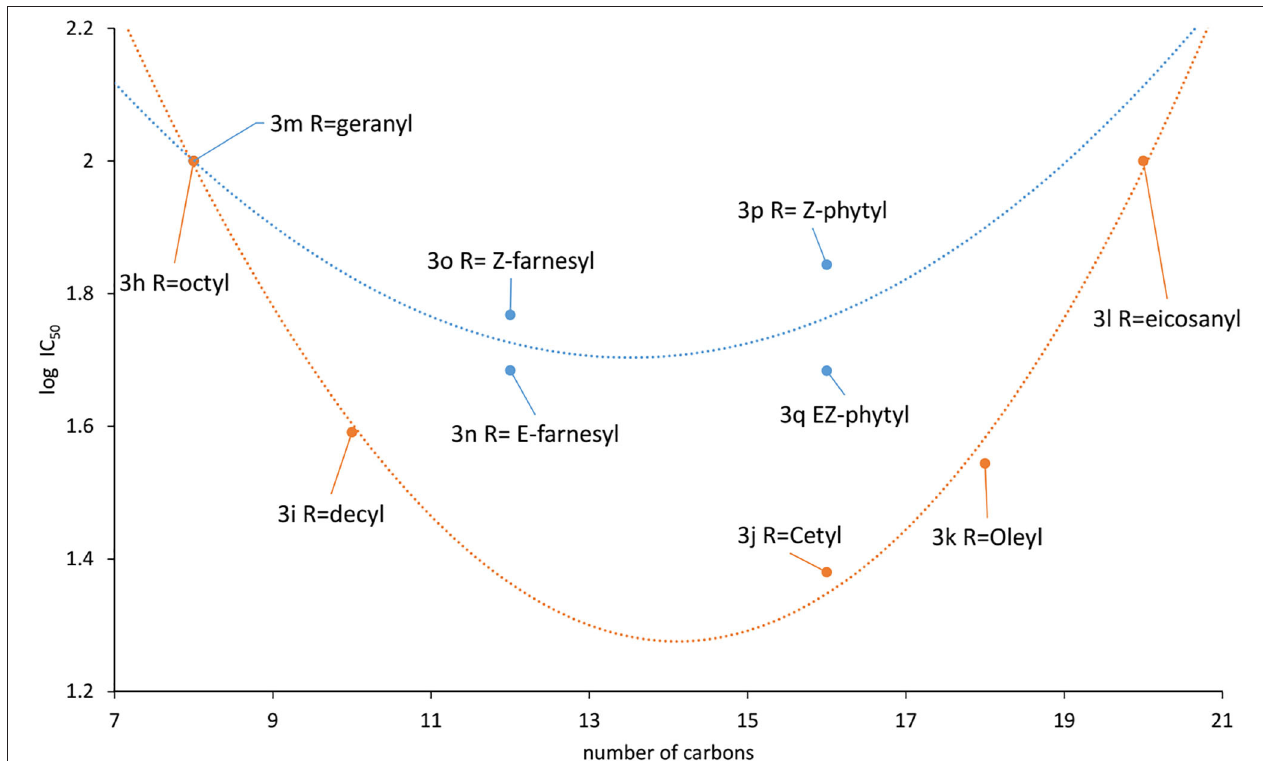
FIGURE 6 | Correlation between activity and substituents chain length (blue: prenyl, orange: